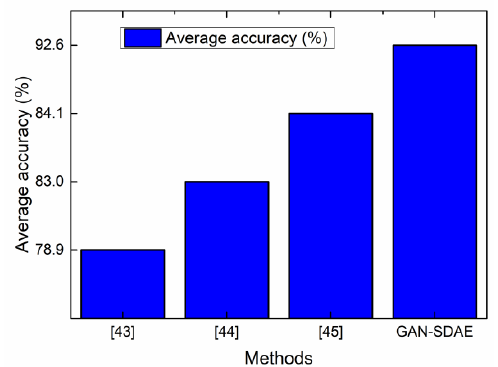
Figure 18. The results of comparing GAN ‐ SDAE with the methods.